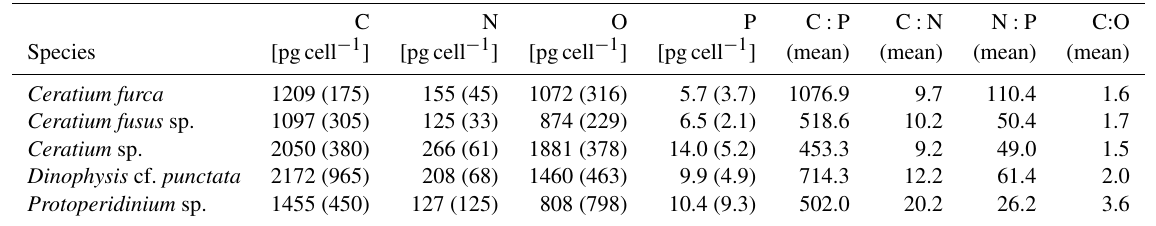
Table 5. Mean and standard deviation (SD) of cellular carbon, nitrogen, oxygen, and phosphorus content of dominant microzooplankton taxa as well as their molar